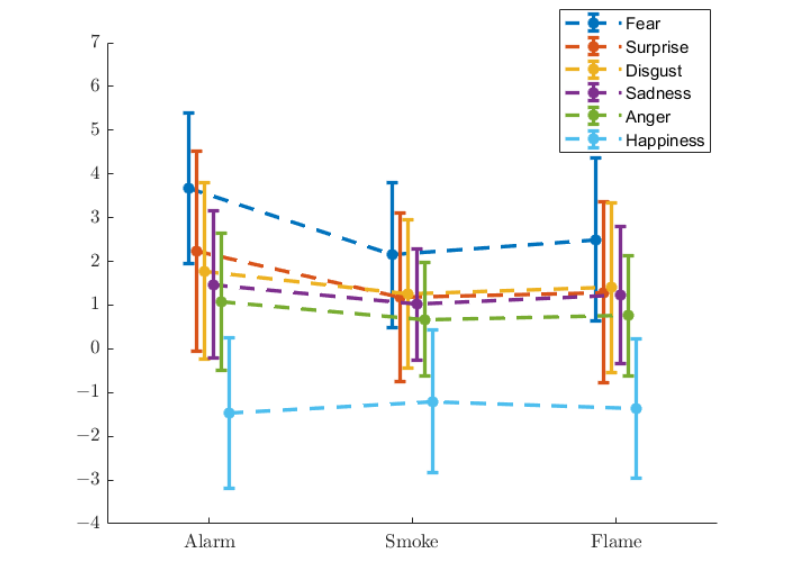
Figure 7. Shifts in basic emotion scores. Table 1. Mean values of basic emotion shifts.